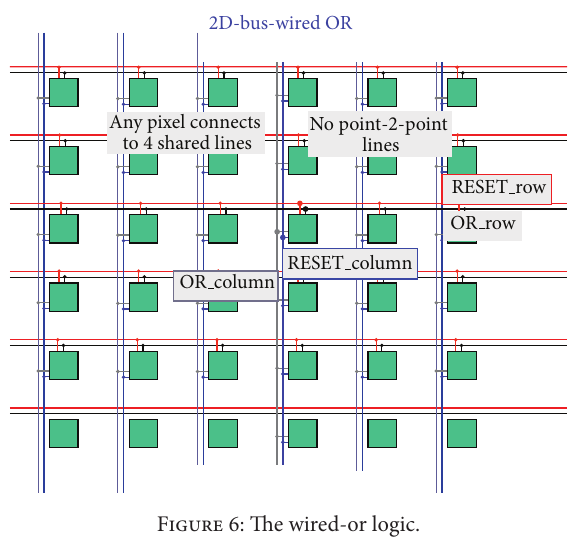
Figure 6: The wired-or